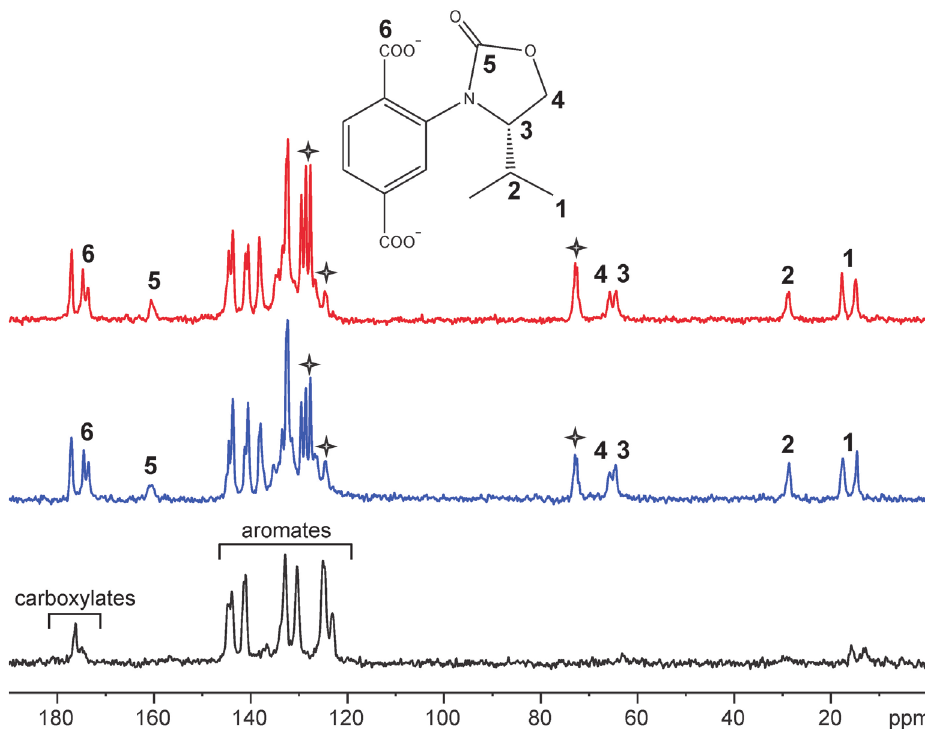
Figure 8. 13 C CP MAS NMR spectra of i Pr-ChirUMCM-1. Top (red): Sample loaded with ( R )-TFPE. Middle (blue): Sample loaded with ( S )-TFPE. Bottom (black): Unloaded sample. The structure of the modified BDC-linker (Chir-BDC) bearing the chiral side group is shown in the figure in order to define the carbon positions of the assigned signals. Stars denote signals due to TFPE (Reproduced with permission from [138], copyright 2012 the Royal Society of